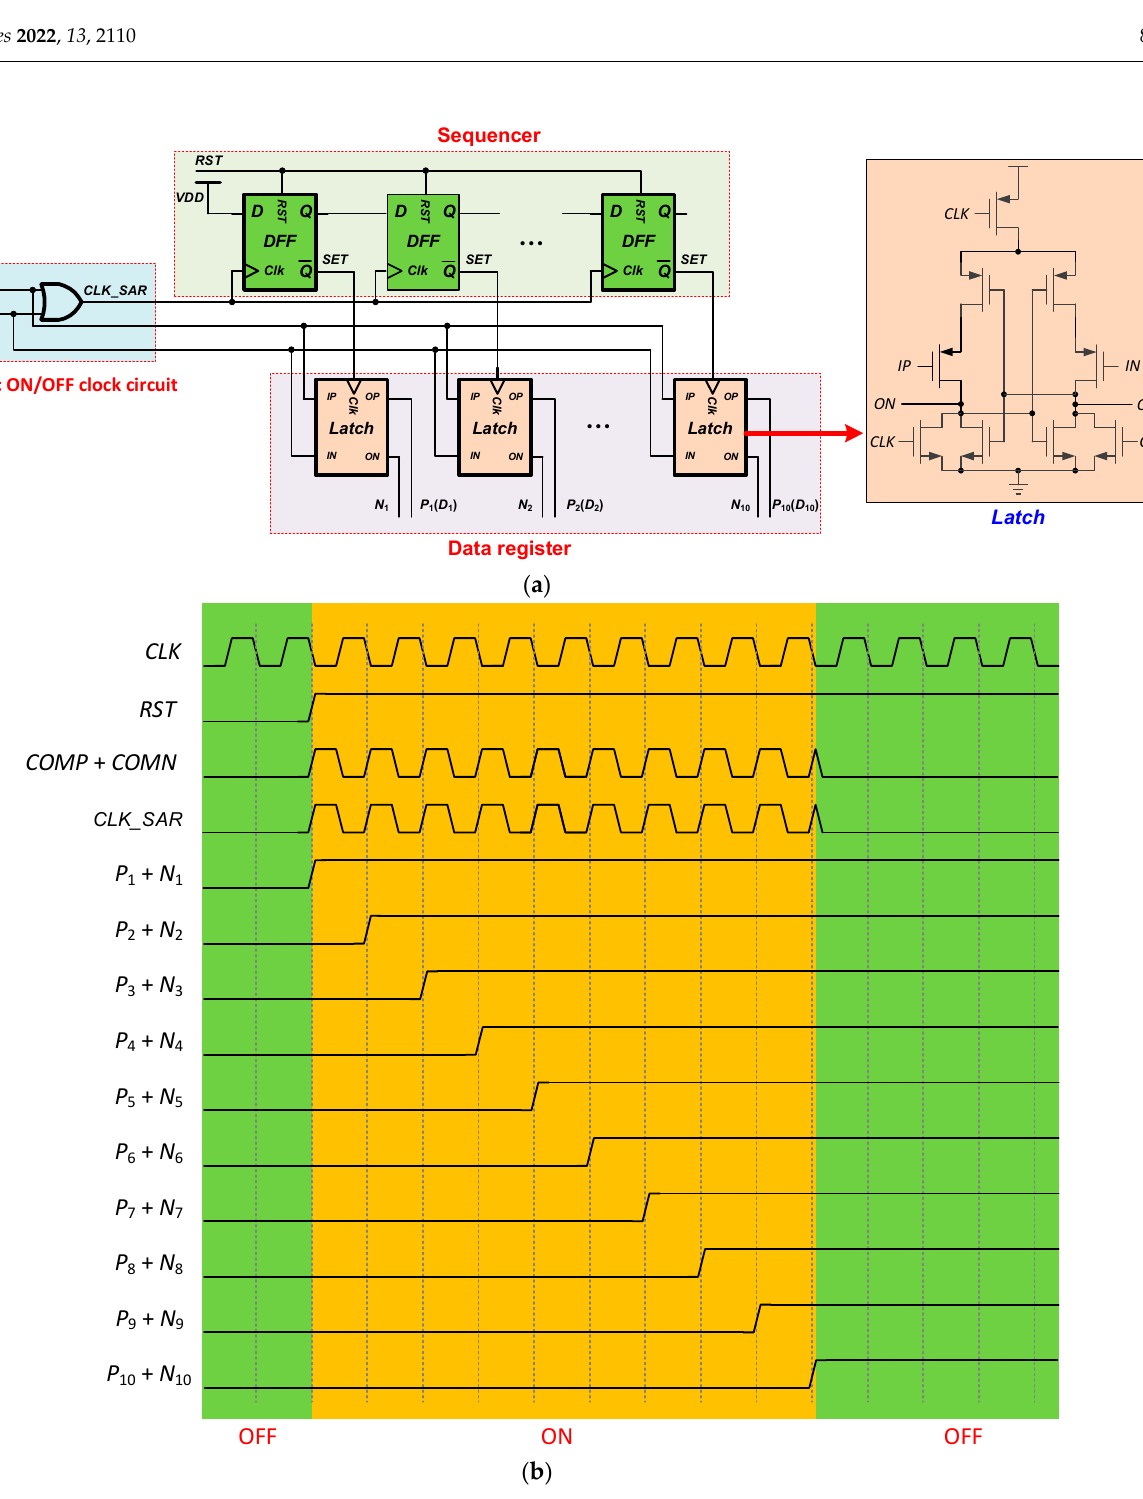
Figure 8. Automatic ON/OFF SAR logic. ( a ) Block diagram; ( b ) Timing diagram.